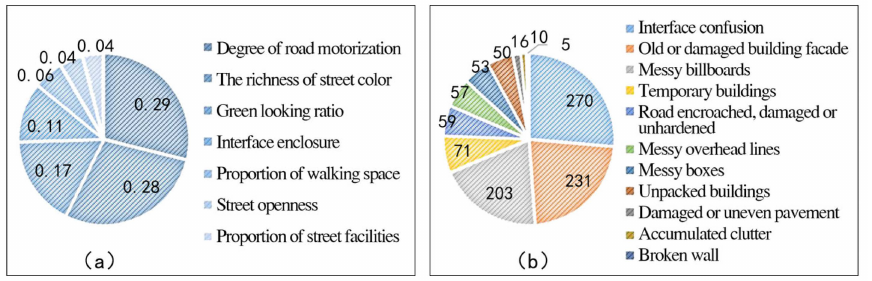
Figure 16. Importance score of the feature elements of arterial roads ( a ) and audit situation of street spatial quality issues ( b ).